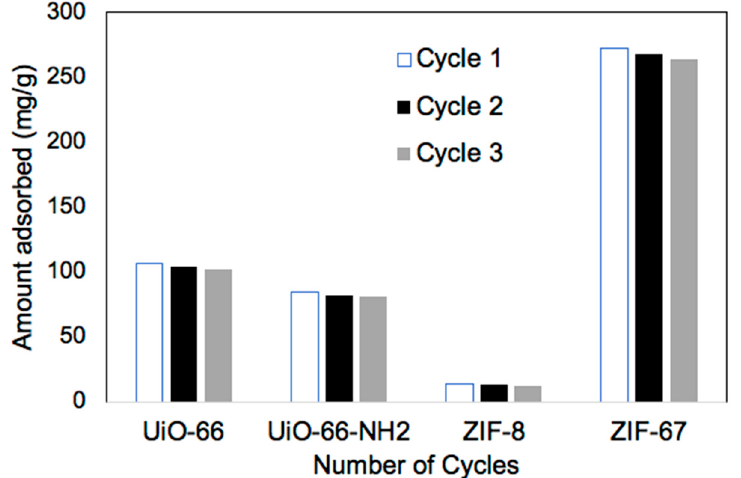
Figure 5. Reusability of MOFs for adsorption of AO7. ZIF-8 and ZIF-67 were washed with acidic ethanol (pH 4), while UiO-66 and UiO-66-NH 2 were washed with basic ethanol (pH = 9).